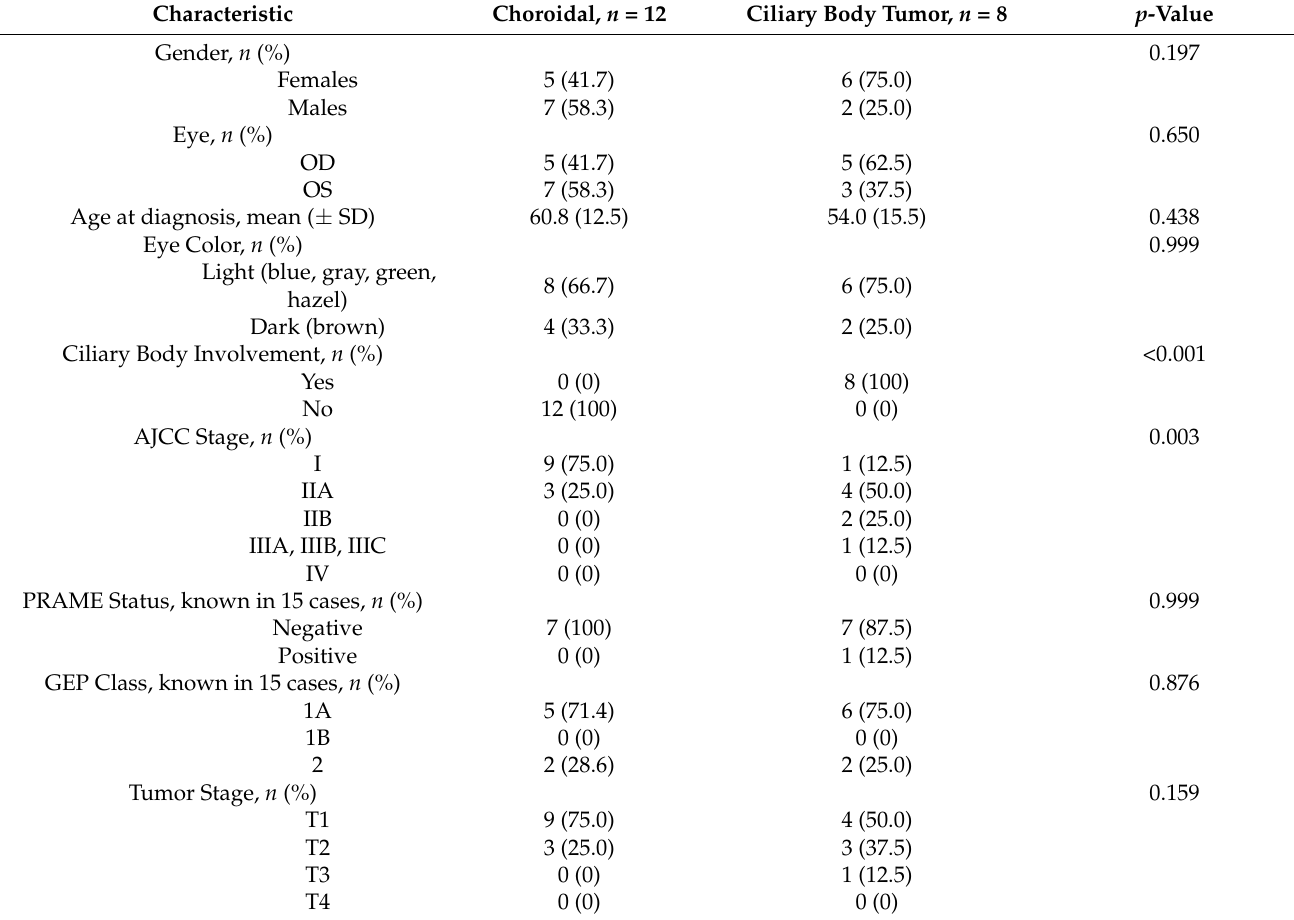
Table 1. Clinical characteristics of choroidal and ciliary body melanoma